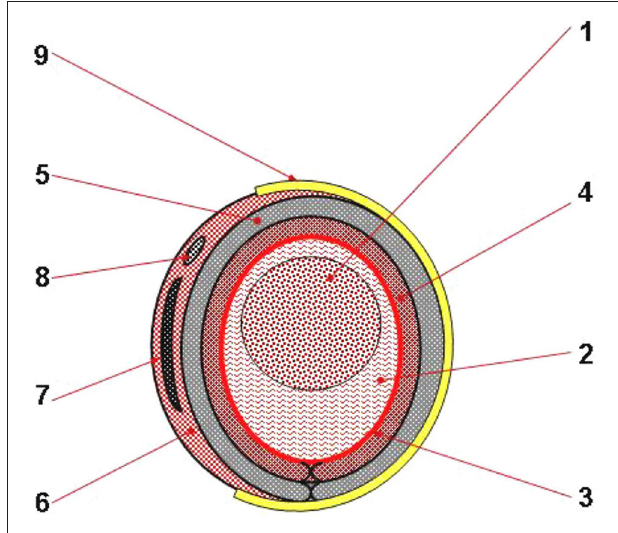
FIGURE 3 | Concept design of a cross section through lower limb(s)’module of the MOD. 1, Bony area; 2, Muscle area; 3, Skin and sucutaneous soft tissues; 4, Textile material for contact with the skin; 5, Pulsed air flow textile structure; 6, (Eeach) exoskeleton’s external part, made of composite material; 7, Metallic insertion; 8, Tubular seating for pull and respectively, electric cables; 9, Fasten system. Reproduced with permission from the publisher (Onose et al., 2012a, pp. 1–99).